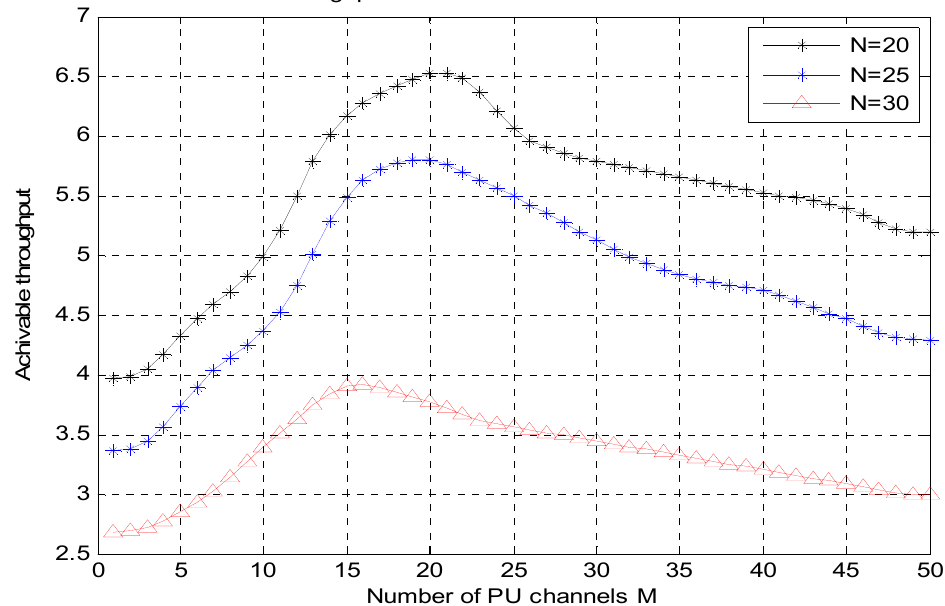
Figure 3. Number of sensed PU channels (M) vs. achievable throughput .